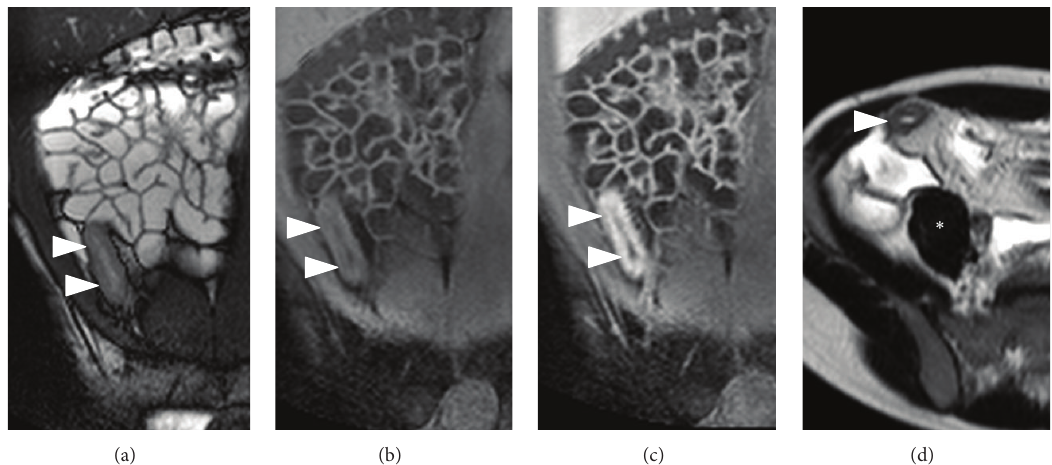
Figure 3: MR-E of a patient with terminal ileitis (ileal SES score 10; overall SES score 15). (a) Coronal B-TFE image. (b) Unenhanced coronal THRIVE image. (c) CE-coronal THRIVE. (d) Axial SSh-T2 image. MR-E shows a 10mm thick, hyperenhancing, and ulcerated terminal ileum (arrowheads). T2 sequence demonstrates mural edema as terminal ileum (arrowheads) shows higher signal intensity than psoas muscle ( ∗ ). MRIA = 31.4; mMRIA = 30.